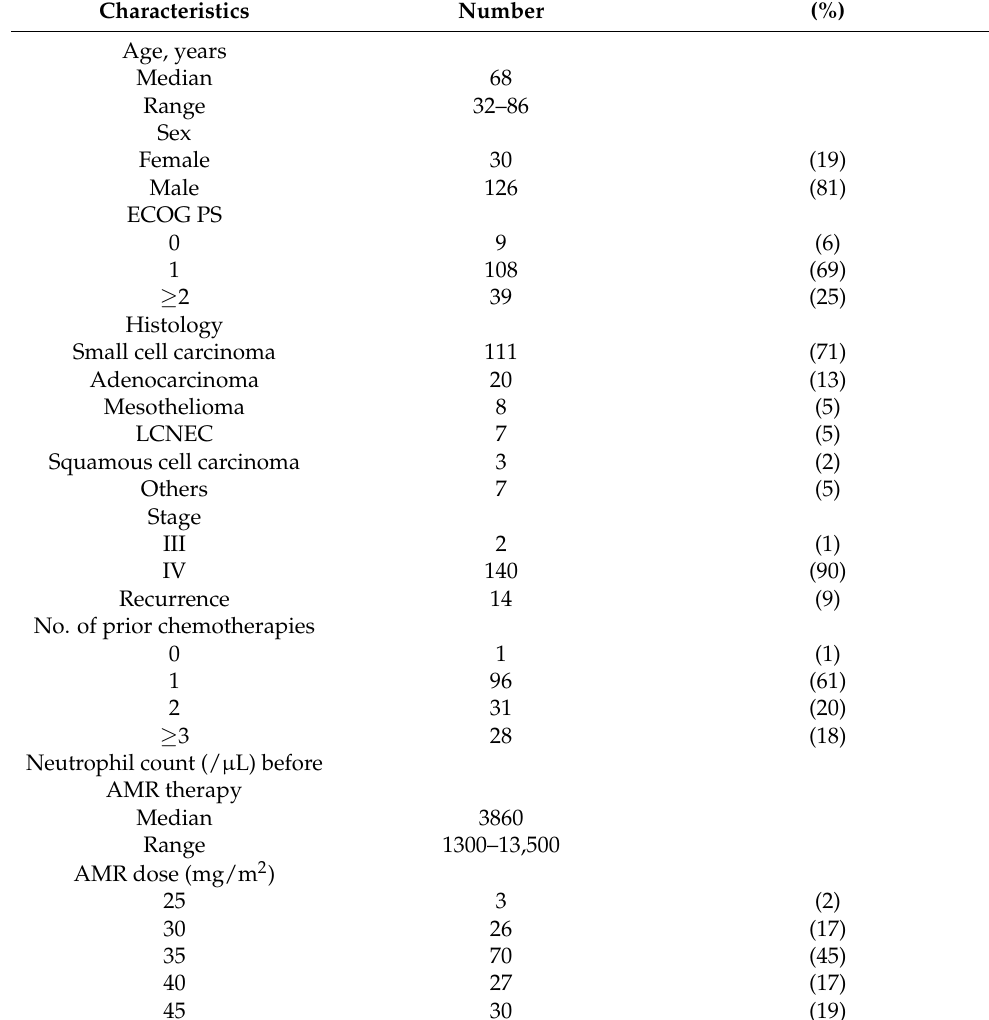
Table 1. Patient characteristics ( N = 156).